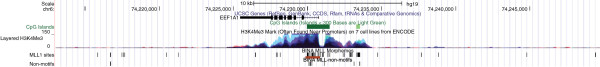
Zoom-out view of MLL1 morpheme occurrences in EE1F1A locus. Horizontal green bars mark the position of CGIs. Horizontal brown bar marks the chromatin segment bookmarked by MLL1 during mitosis [31]. Track-labeled “MLL1 sites” marks morpheme positions; “non-motifs” mark the position of sequences not found in results of SELEX assays [24]. Track labeled “Layered H3K4me3” shows the position of H3K4me3 marks [59].